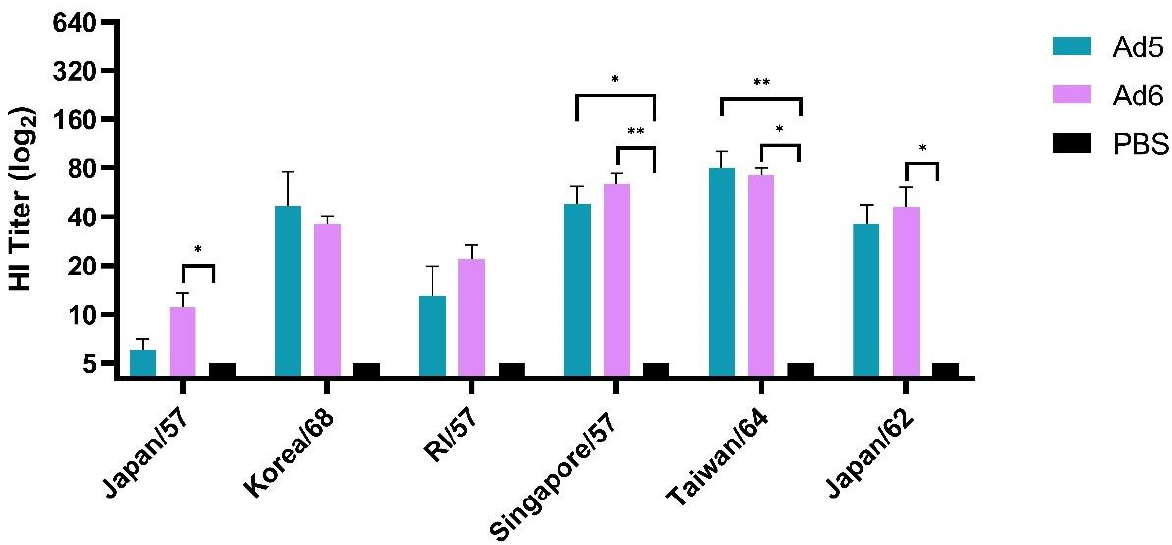
Figure 2. Hemagglutinin inhibition (HI) titers after prime vaccination. BALB/c mice ( n = 5) were immunized with 10 10 viral particles (vp) of Ad5-H2-Con, Ad6-H2-Con, or DPBS. Sera from immunized animals were assayed for HI antibody titers against a range of divergent human H2 influenza A viruses. Data are represented as the mean HI titer with standard error (SEM). ( n = 5; statistical analysis based on one-way ANOVA with Tukey multiple comparison; * p < 0.05, ** p < 0.01).